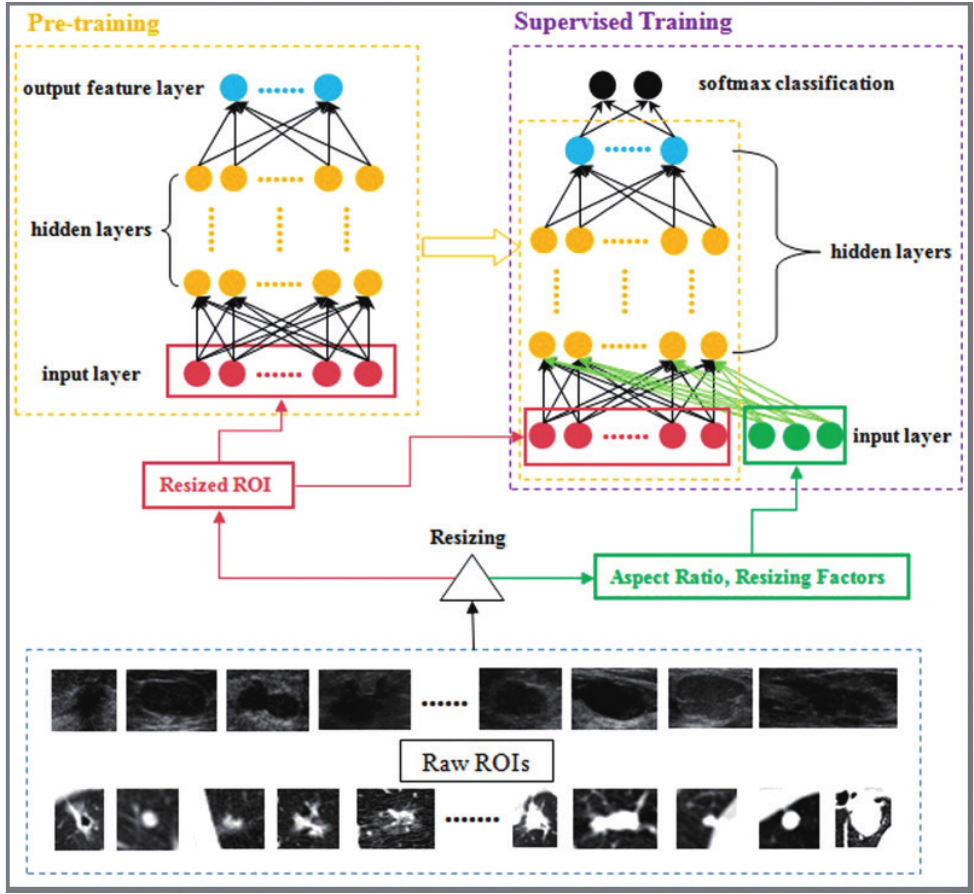
Figure 4 Flow-chart of the deep-learning-based CADx training framework. The pixels of resized (the region of interest) ROIs are fed into the network architecture at the pre-training step. The pre-trained network is then refined with the supervised training by adding three neurons carrying aspect ratio of the original ROI and also the resizing factors at the input layer. The final identification result can be made with the softmax classification. (Reprinted with permission from